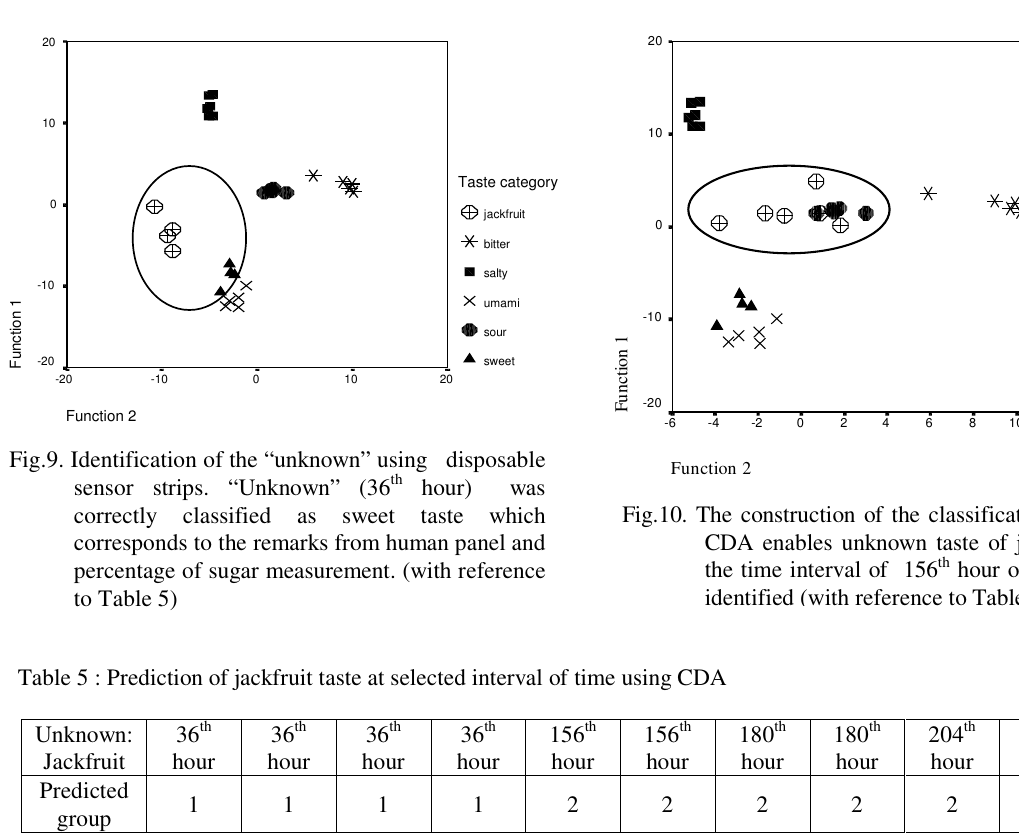
The evaluation of the jackfruit taste using disposable sensor strips was shown in Fig 9, 10 and Table 5. The taste of the jackfruit stored until the 36 th hour was found correlated with the results obtained using refractometer and human sensory.